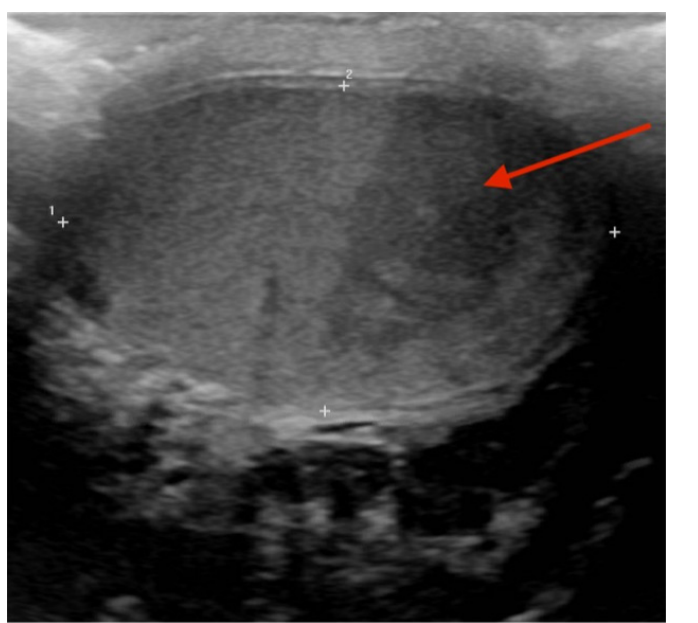
Image 1. A hypoechoic wedge-shaped area (arrow) seen on ultrasound in the right testicle on sagittal view.